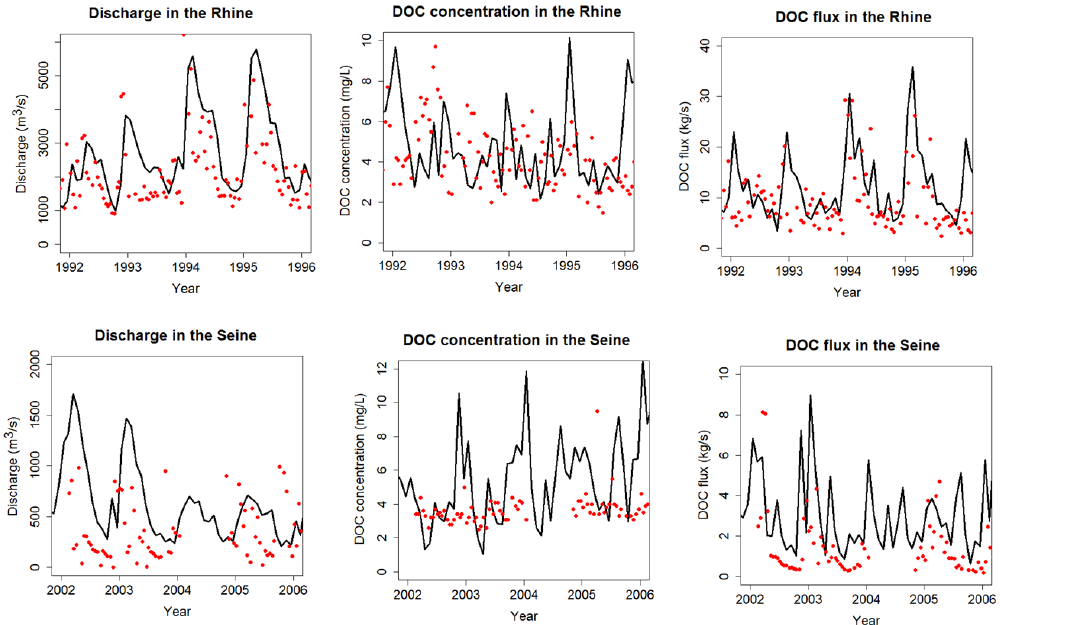
Figure 10. Time series of discharge (a, d) , DOC concentration (b, e) and DOC fluxes (c, f) in the Rhine at Lobith ( a – c , period 1992–1996) and in the Seine at Poses ( d – f , period 2002–2006. See Fig. 3 for location of stations. Black lines are for ORCHILEAK and red dots for